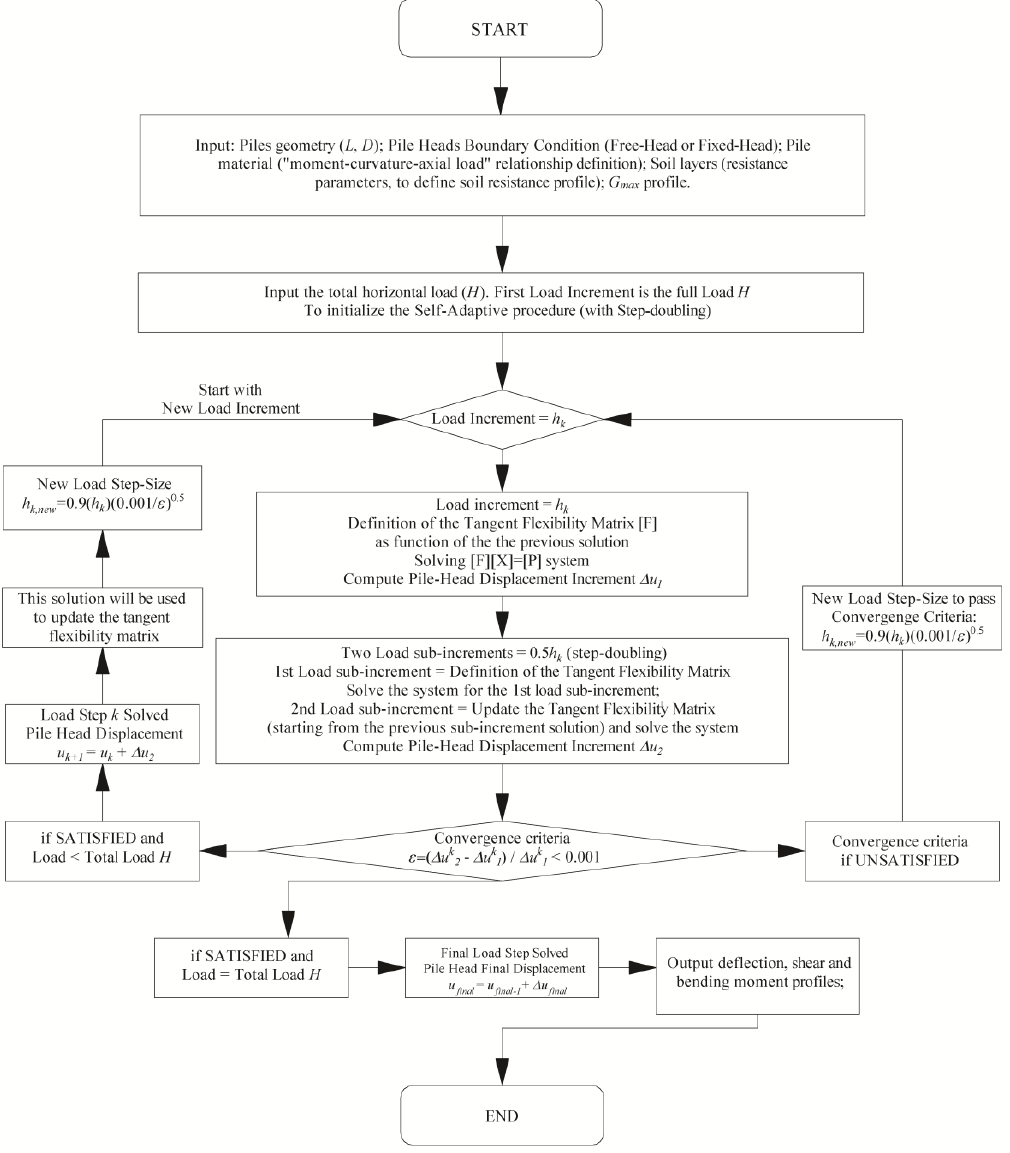
Figure 9. Flow chart of the proposed non-linear adaptive step-size method.